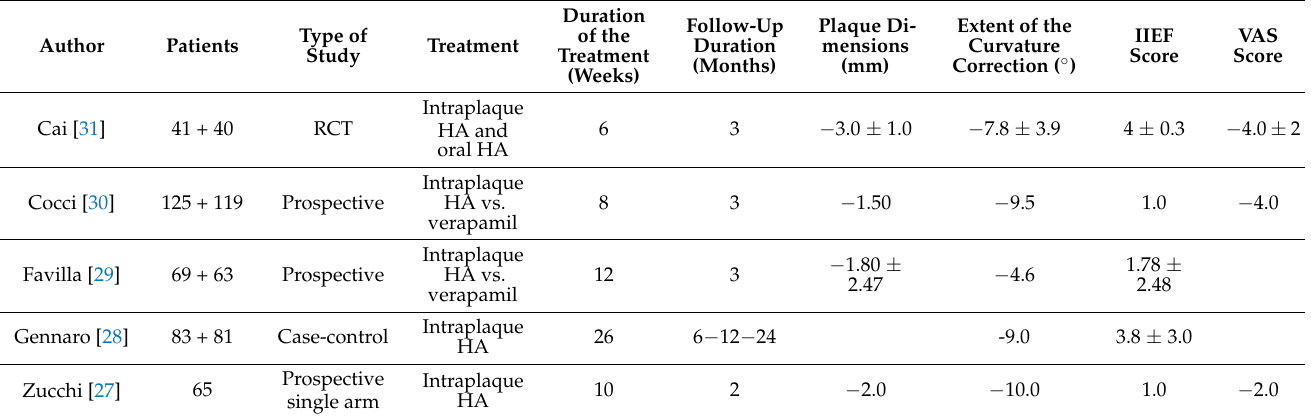
Table 2. Studies dealing with the use of HA to treat